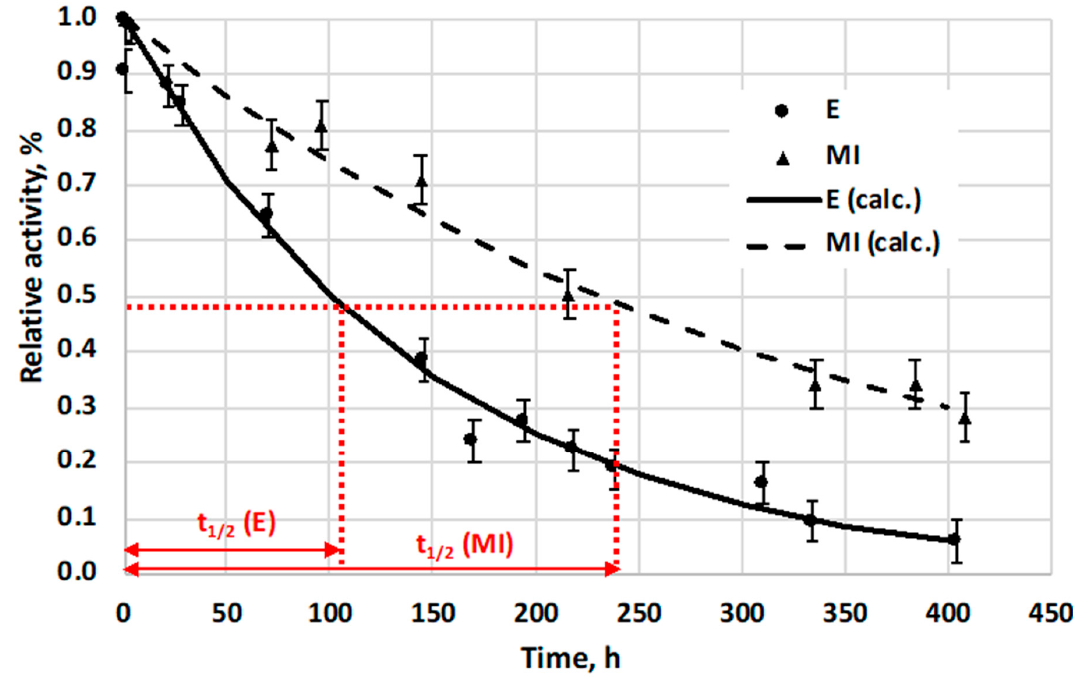
Figure 8. Reduction of activity of immobilized α -chymotrypsin enzyme into porous support layer of membrane (MI) compared to activity change of the not immobilized enzyme (E) measured at the same temperature (23 ◦ C). Half-life times of E and MI were predicted from a scale and decay constants ( λ ) of E and MI, using Equations (2)–(5). These calculated relative activity values are continuous line (E) and dash-line (MI). The measured (points) and the predicted values agree excellently well. (Standard error values are plotted. They have varied between ± 3.8% up to ±